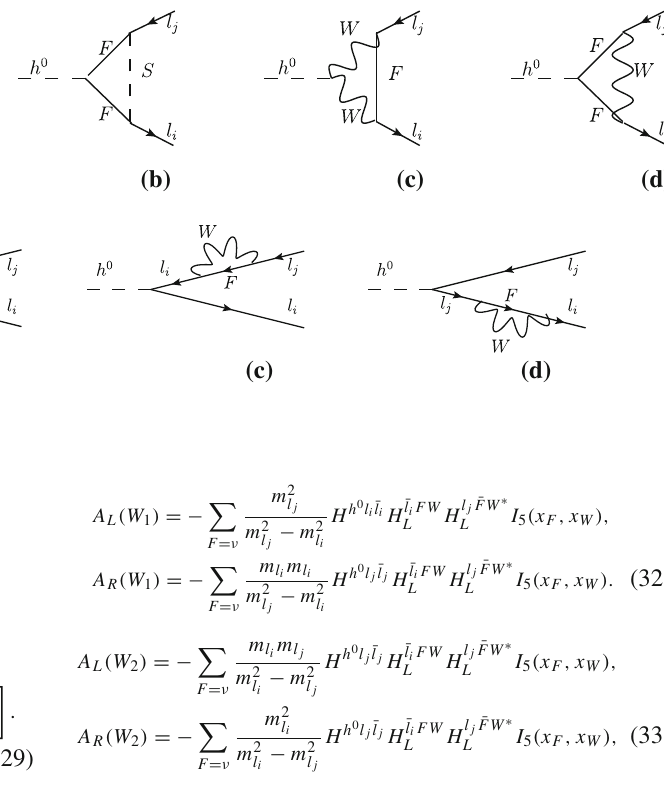
( x , x , x )( i = 1 , 2 ) are 1 2 3 collected in “Appendix”. The decay widths for processes h 0 → l i l j are deduced here (cid:5) (cid:6) (cid:5) (cid:6) ¯ = 1 | N | 2 + | N | 2 h 0 → l i l j m where (cid:18) [47,48]. L R h 0 16 π ¯ l j are same Correspondingly, the calculations for h 0 → l i ¯ l i l j . as those for h 0 → Above all, the branching ratios of h 0 → l i l j can be sum- marized as